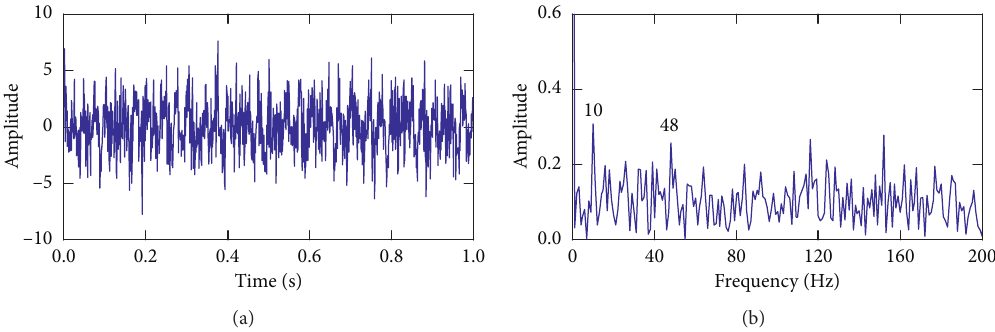
Figure 3: Time-domain diagram and envelope spectrum of simulation signal y ( t ).